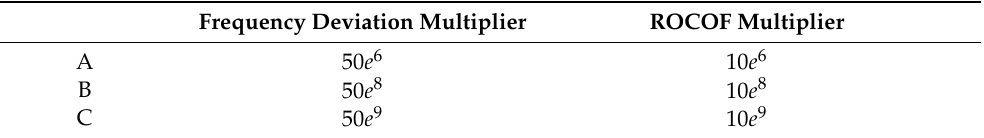
Figure 5. Variations in grid frequency, WTs’, and synchronous machines’ responses during different battery control scenarios. Table 4. Battery gain